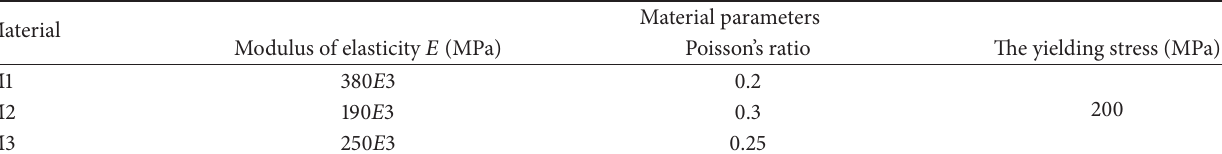
Table 5: The three different material models.